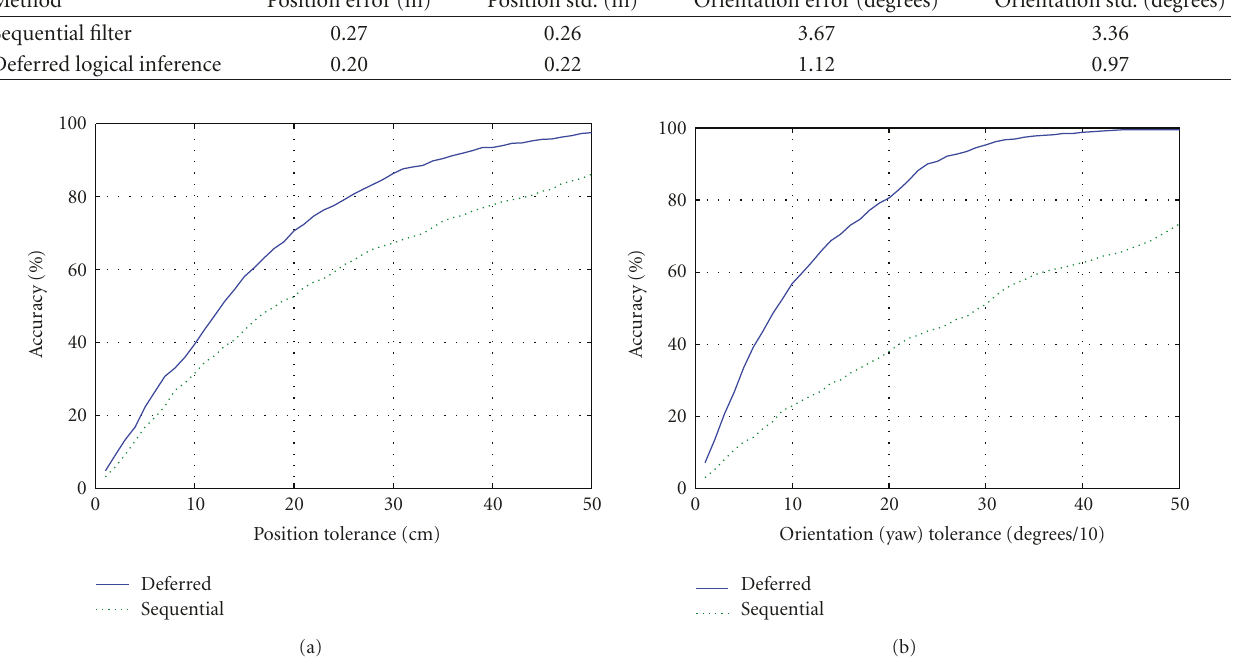
Figure 7: Percentage of correct position/orientation related to the tolerance. (a) position absolute tolerance. (b) orientation (yaw angle) absolute